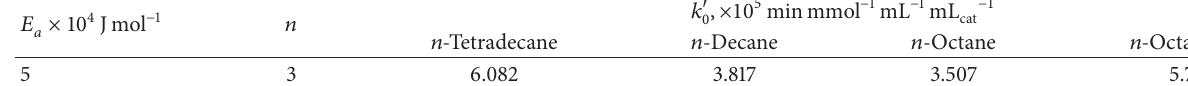
Table 2: Parameters for (4) and (5).